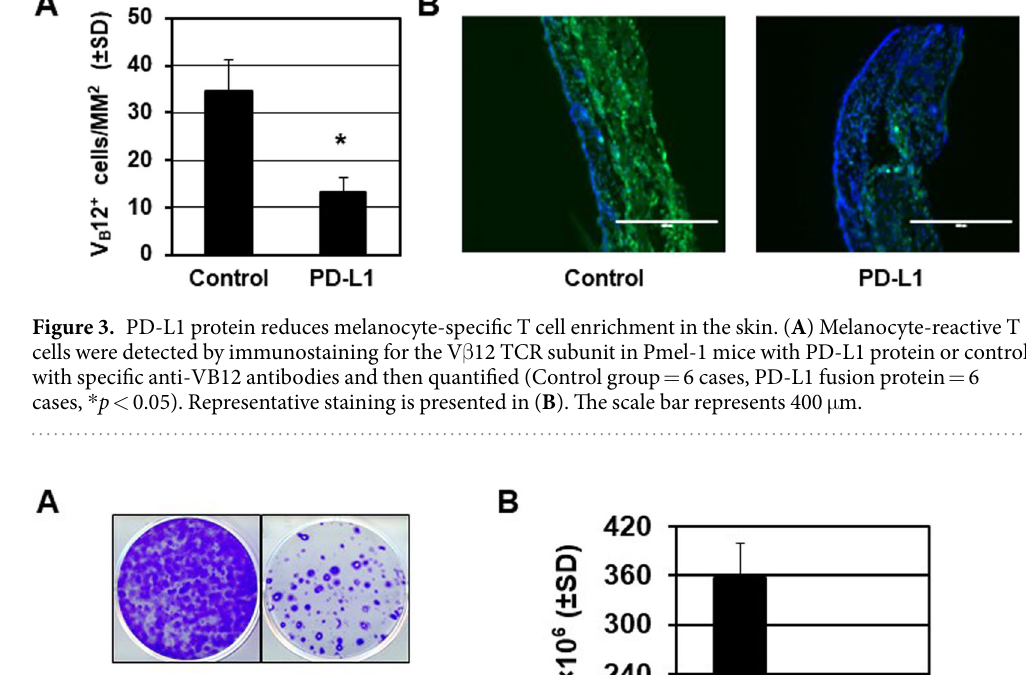
in vitiligo development in clinical trials of cancer 22 .